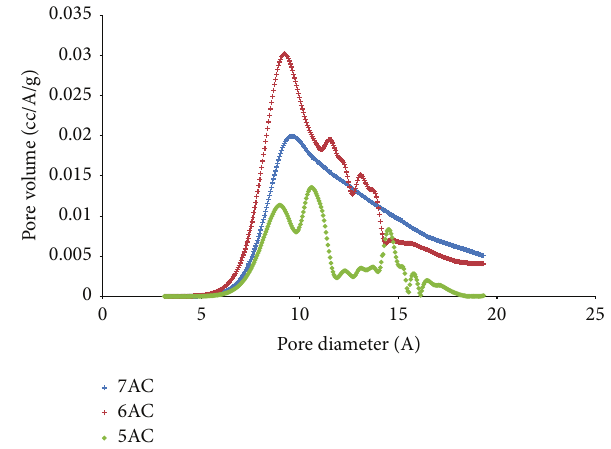
Figure 4: PSD of palm shell activated carbon using H-K